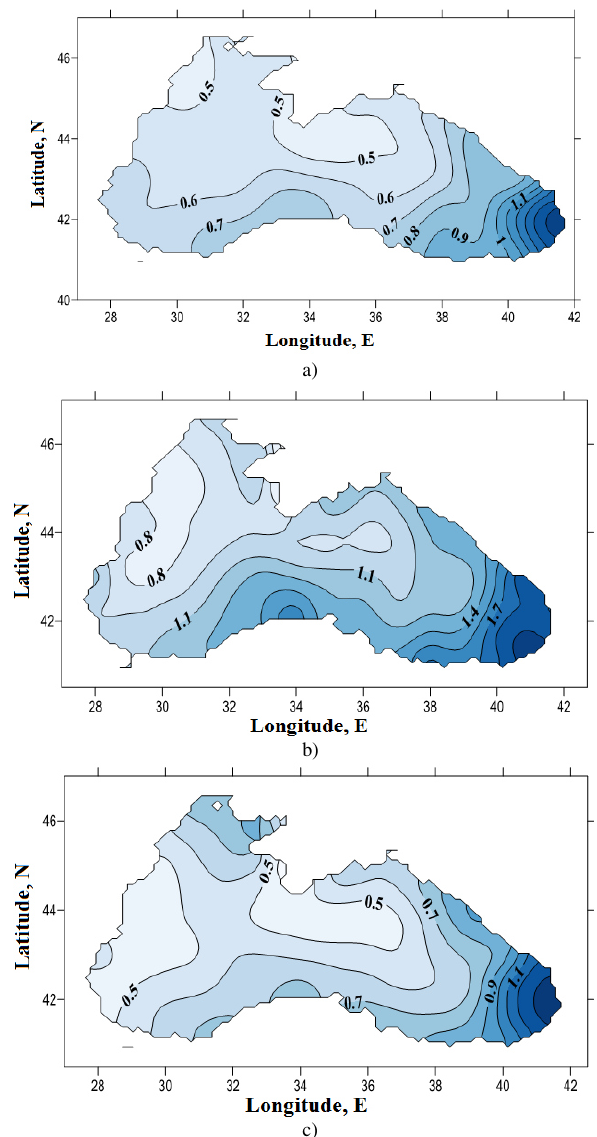
Figure 4. The annual IFN deposition (tNkm − 2 yr − 1 ) with atmo- spheric precipitation at the Black Sea surface: the average values from 2004 to 2008 (a) , the highest annual values in 2005 (b) , the lowest annual values in 2008 (c) .